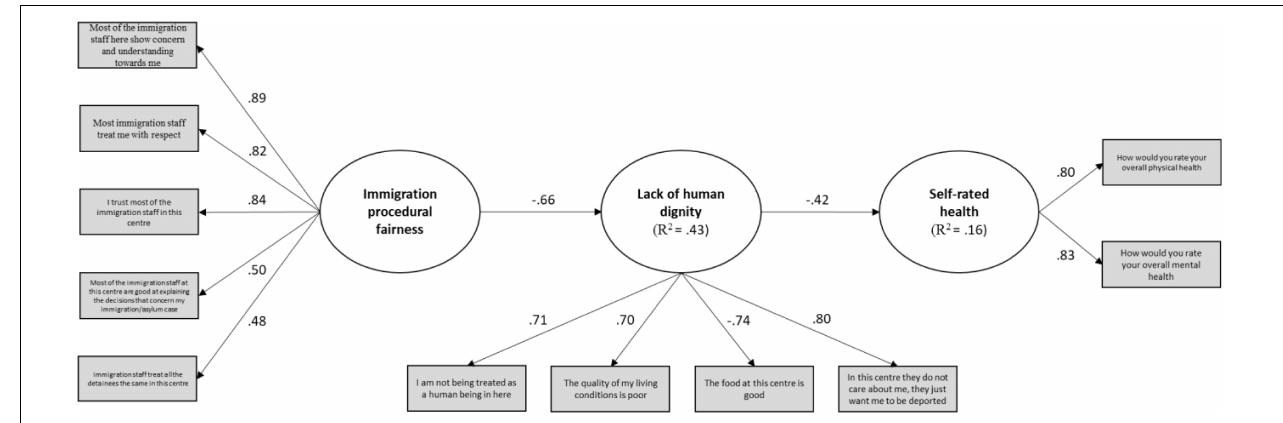
FIGURE 1 | Structural model of relationship between Immigration procedural fairness, Lack of human dignity, and Self-rated health. TABLE 3 | Structural model results of direct and indirect effects. Path Standardised path